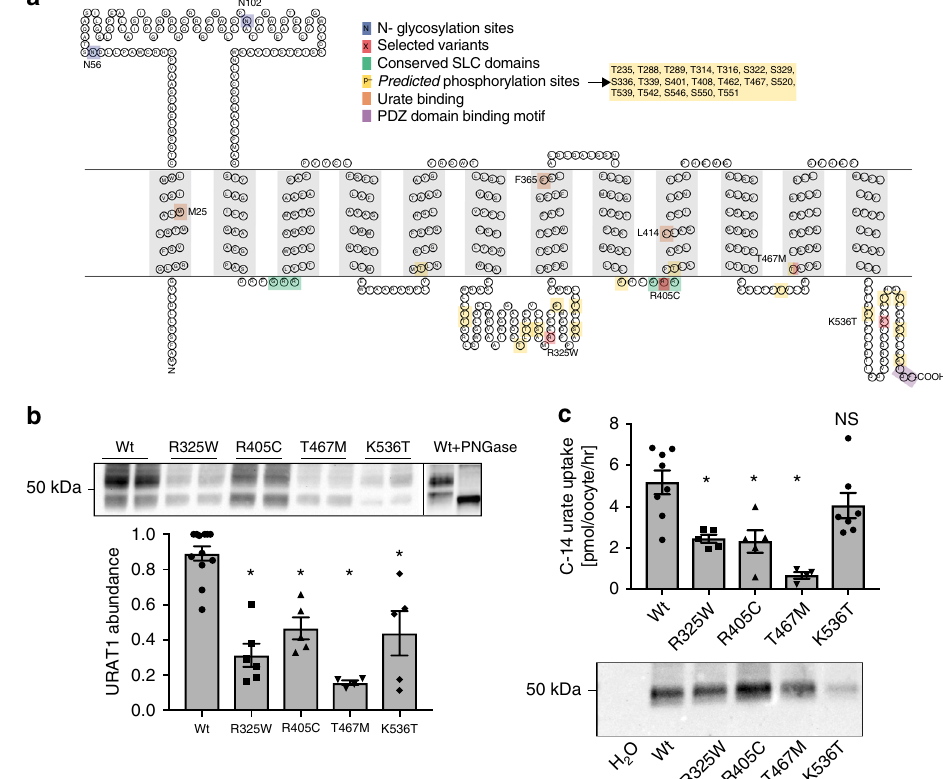
Fig. 2 Topology and experimental results of four damaging variants in SLC22A12 . a Topology of SLC22A12 gene product URAT1 with position of variants tested marked in red. Also marked are glycosylation sites (blue); conserved domains (green); predicted phosphorylation sites (see Supplementary Methods; yellow); proposed urate-binding residues (orange); and the PDZ domain binding motif (purple). b Abundance of URAT1 mutant constructs in HEK293T cells, glycosylation revealed with PNGase, and summary data; n = 4 to 12; ±SEM; * p < 0.0001 (ANOVA with Dunnett ’ s multiple comparison test). Each lane represents a separate experiment run, processed, and quanti fi ed in parallel. The line in the image denotes the separation between two separate blots. c Summary data from Xenopus oocytes accumulation assay using C-14 labeled urate (see methods). URAT1 mediated urate transport rates with the H 2 O injected control transport rate subtracted ( fl ux of the H 2 O injected controls was 4.3 [pmol/oocyte/hr]); n = 10 to 16 oocytes (processed in 5 to 8 pairs); ±SEM; * p < 0.01 (ANOVA with Dunnett ’ s multiple comparison test). Western blot shows the total abundance of each variant upon equal mRNA injection; lysates from 4 – 5 pooled oocytes for each construct. Note: in Xenopus oocytes the URAT1 monomer migrates as a single band unlike what